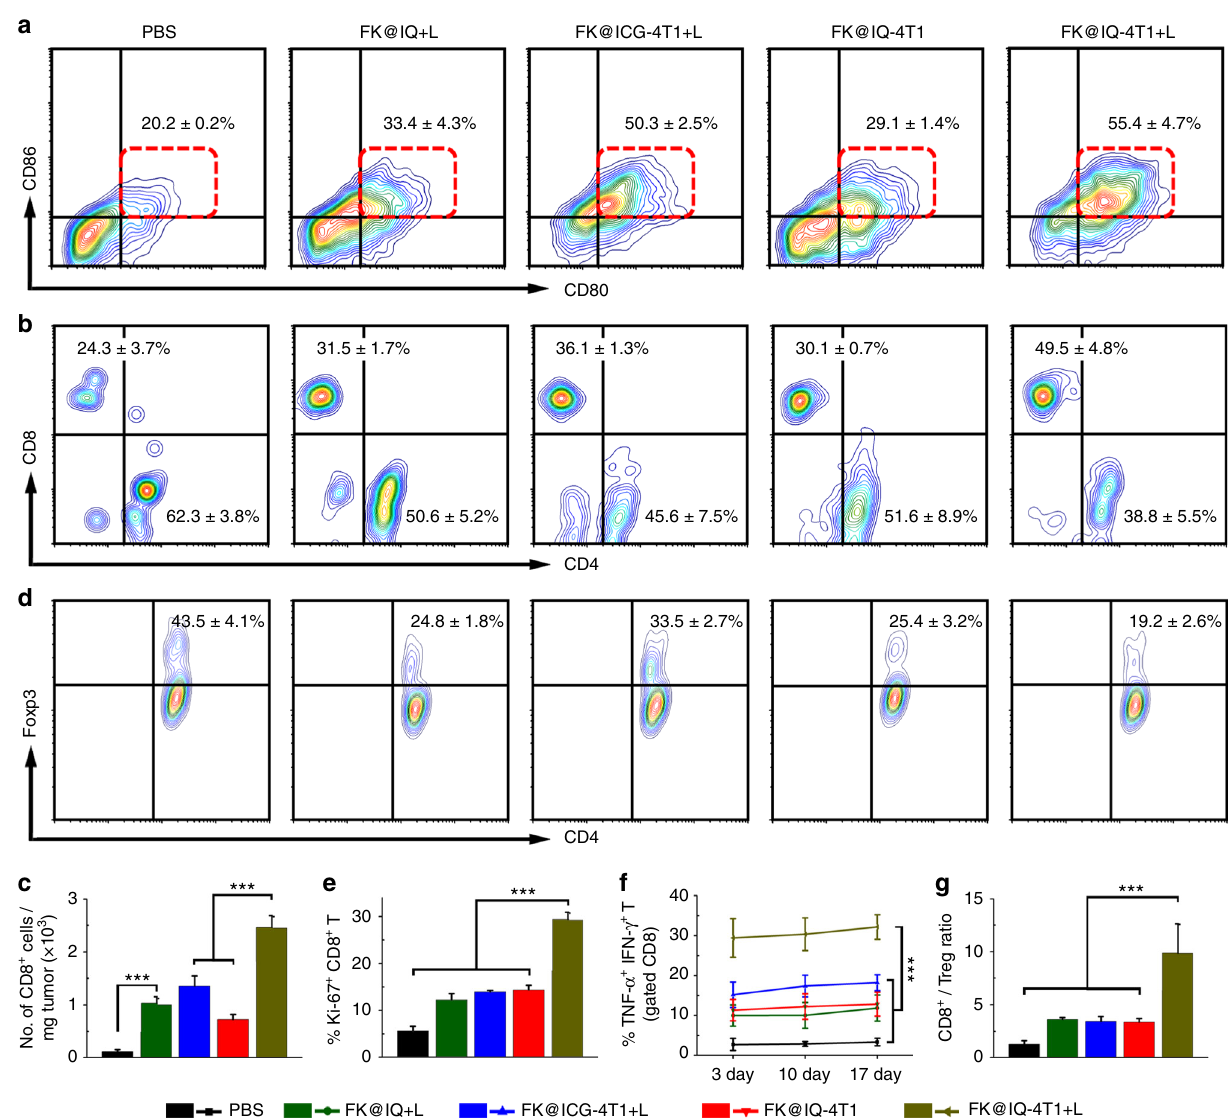
Fig. 5 Vaccine-induced antitumor immunity in vivo. a The hydrogel vaccines accelerated DC maturation (CD11c + CD80 + CD86 + ) in the tumor examined 3 days post treatment. Data represent mean ± s.d. ( n = 3). b Flow cytometric examination of the intratumoral in fi ltration of CD4 + and CD8 + T cells (gated on CD3 + T cells). Data represent mean ± s.d. ( n = 3). c Tumor mass-normalized intratumoral in fi ltration of CD8 + T cells in the recurrent tumors